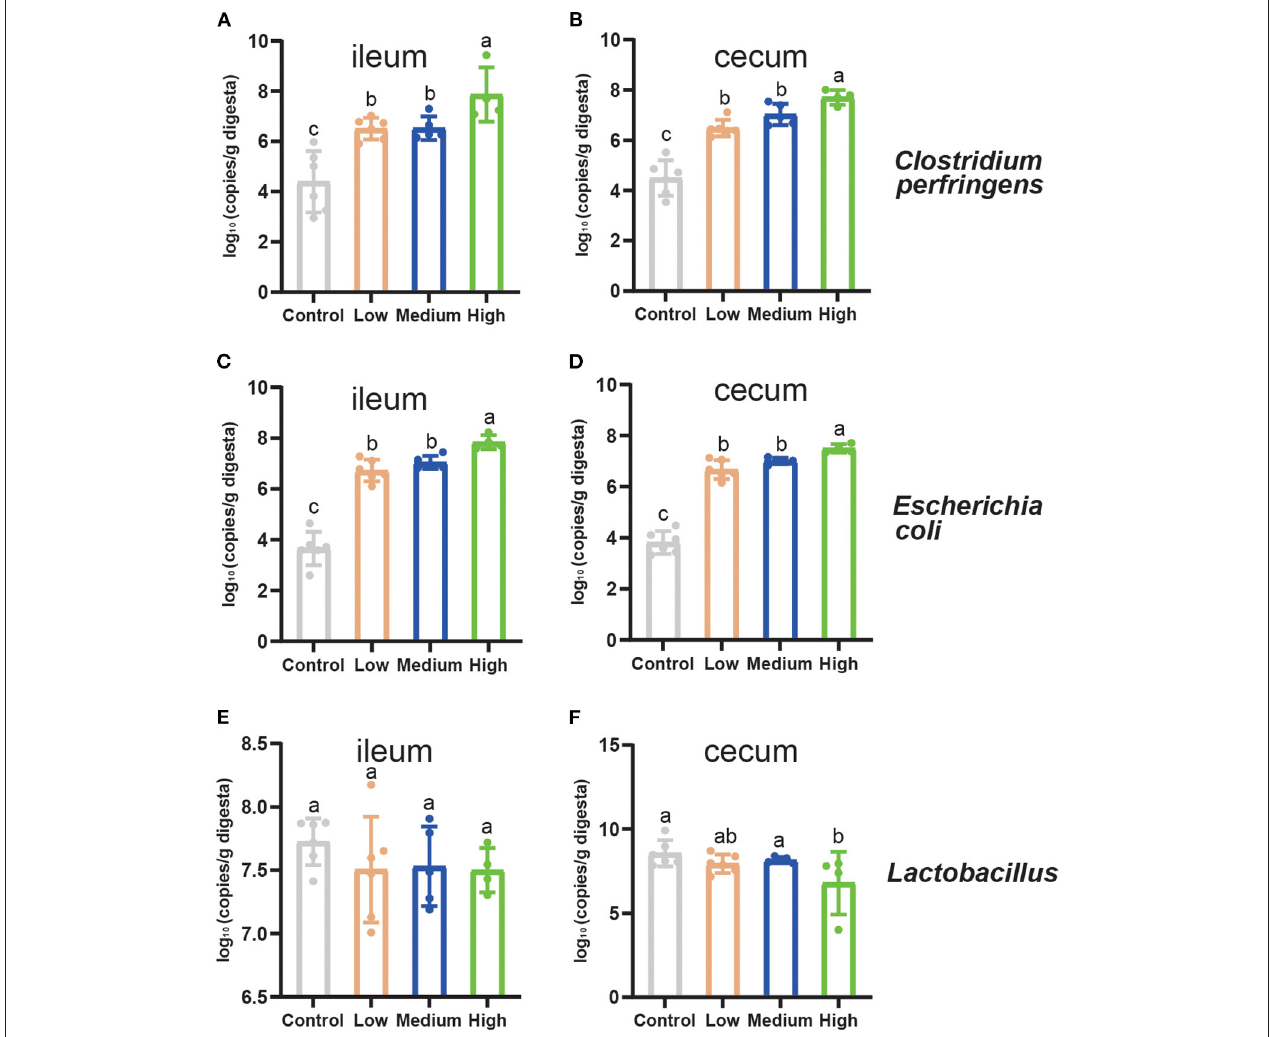
FIGURE 8 | The quantitation of intestinal microbiota of mice on d 8. (A) The population of Clostridium perfringens in the ileum. (B) The population of Clostridium perfringens in the cecum. (C) The population of Escherichia coli in the ileum. (D) The population of Escherichia coli in the cecum. (E) The population of Lactobacillus in the ileum. (F) The population of Lactobacillus in the cecum. Tight junctions related genes expression in the jejunum of mice. Results are presented as mean ± SD (The data were presented as log 10 gene copies/g of intestinal digesta). a , b , c Means values with dissimilar letters were significantly different ( P <